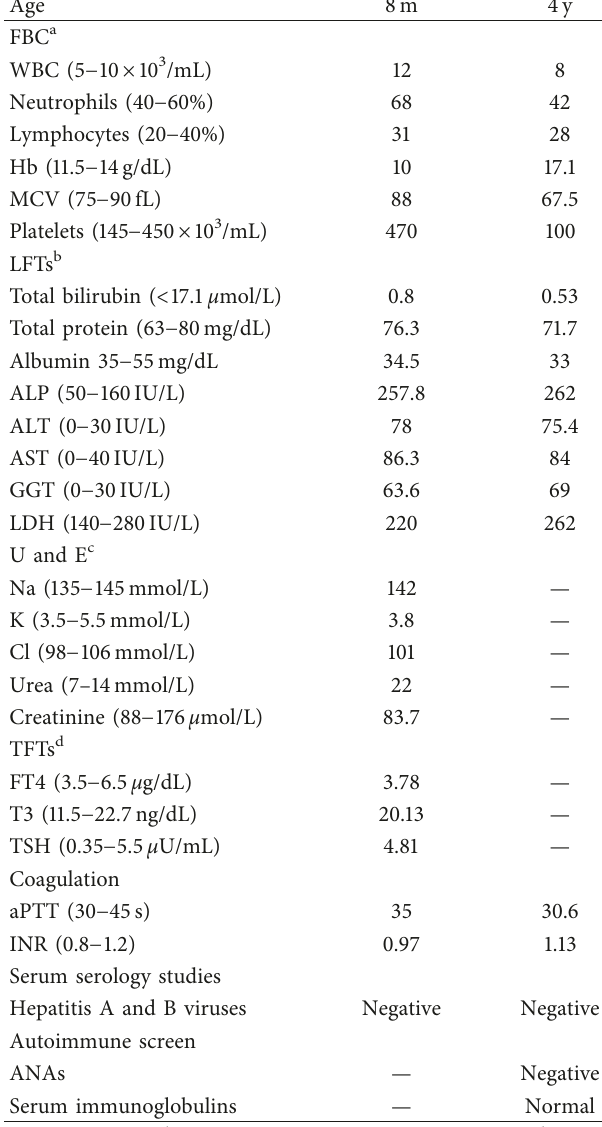
Table 1: Laboratory results.